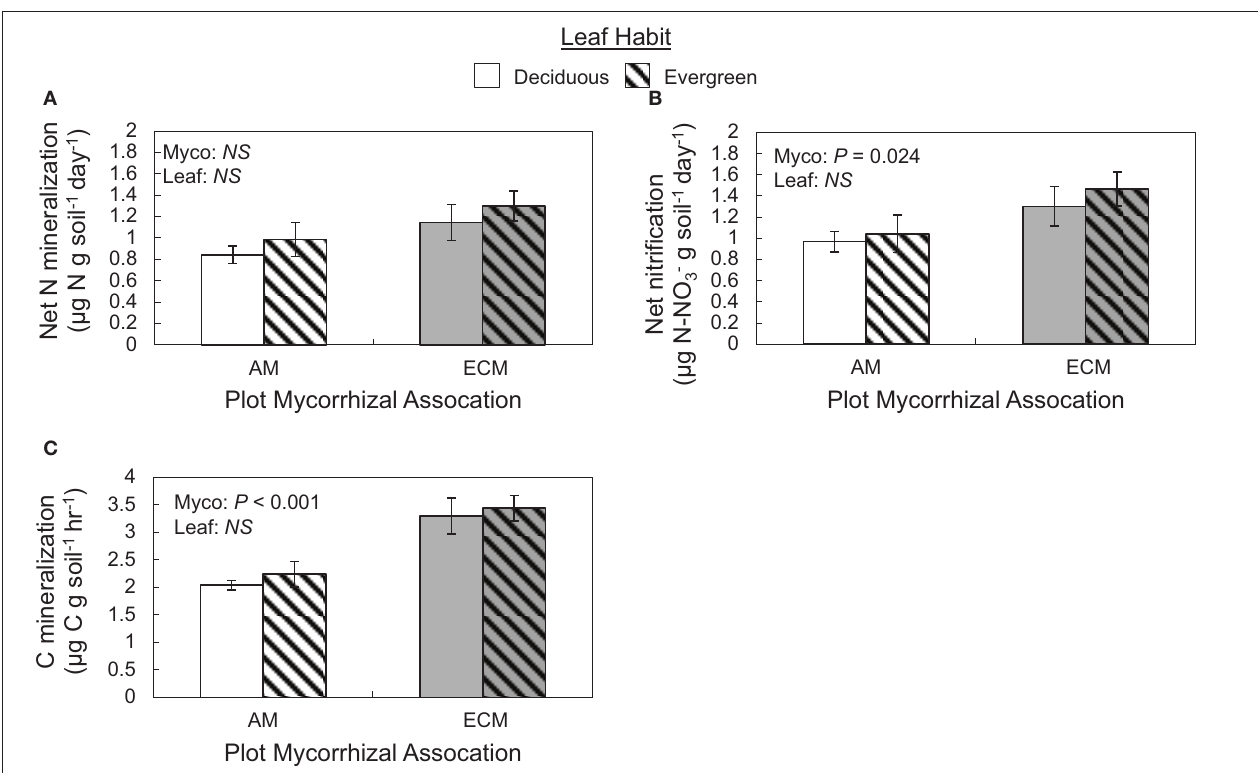
FIGURE 5 | Rates of ex situ net nitrogen mineralization (A) , net nitrification (B) , and carbon mineralization (C) in soils collected from forestry plots at The Morton Arboretum. Bars are mean ratios; one standard error of the mean is presented. Open bars, deciduous plots; hatched bars, evergreen plots; white bars, AM plots; gray bars, ECM